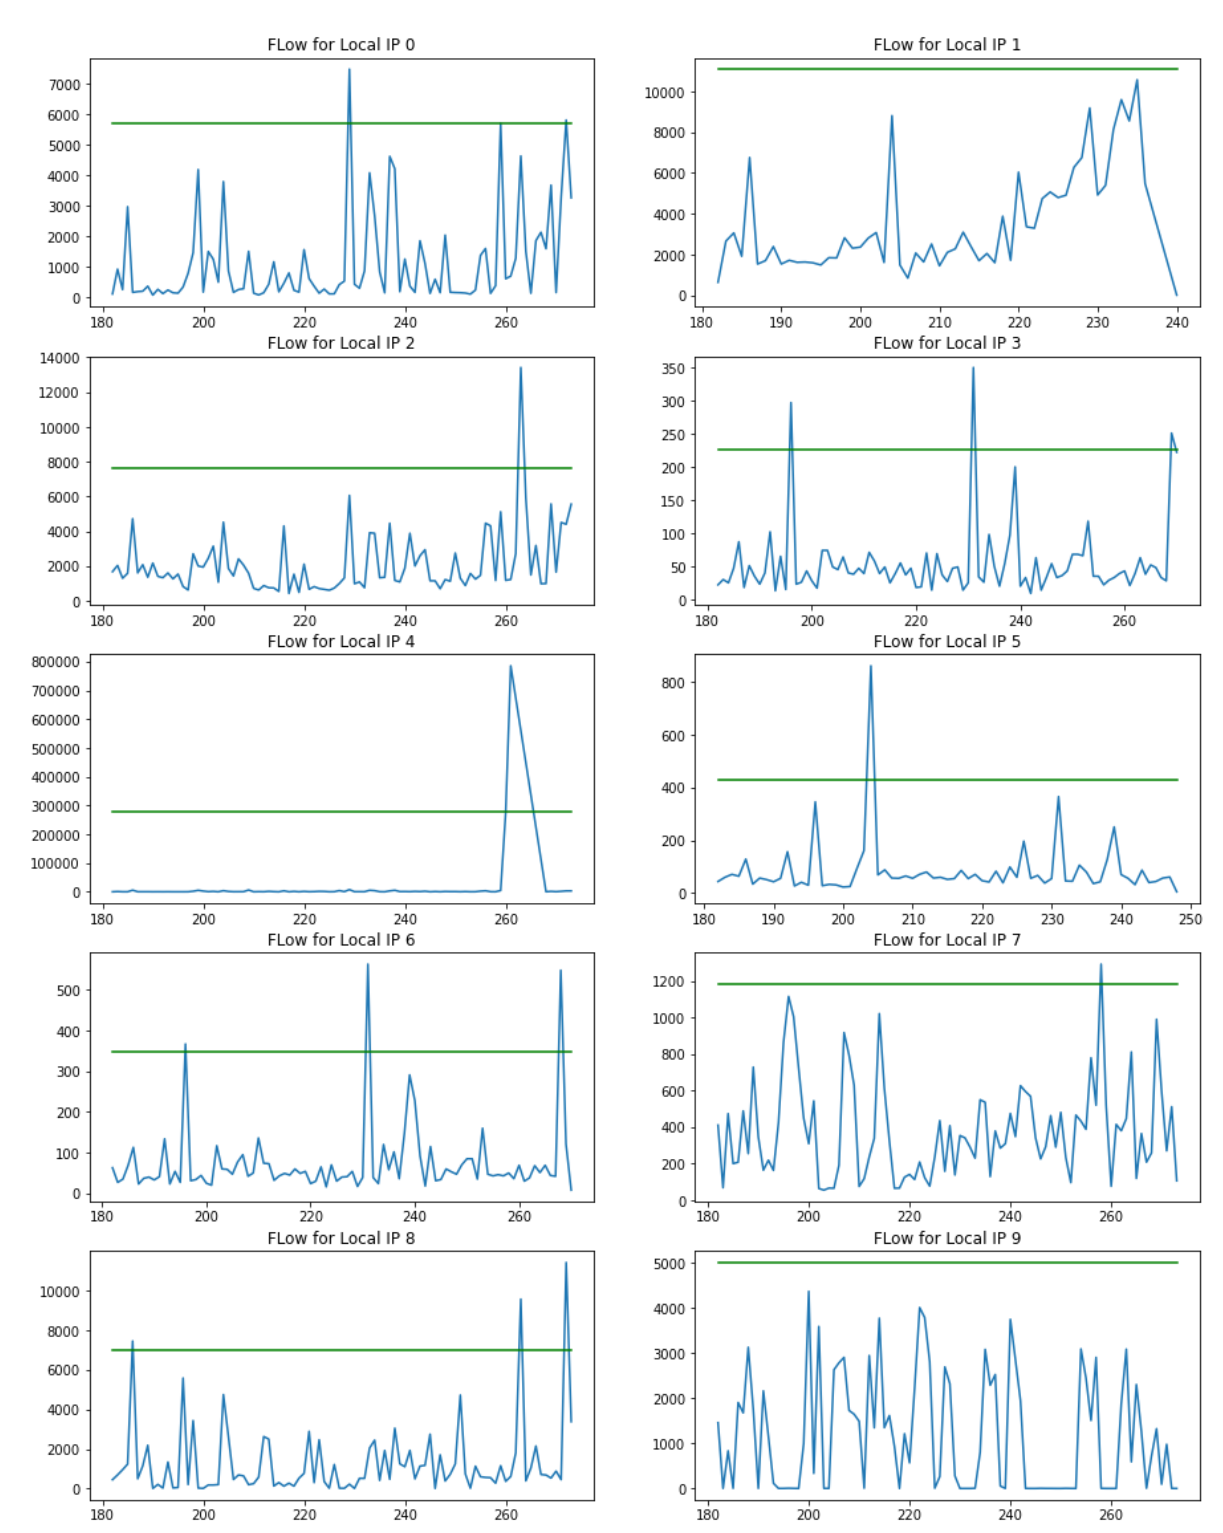
Figure 3. The flow of the IP addresses and maximum packets.